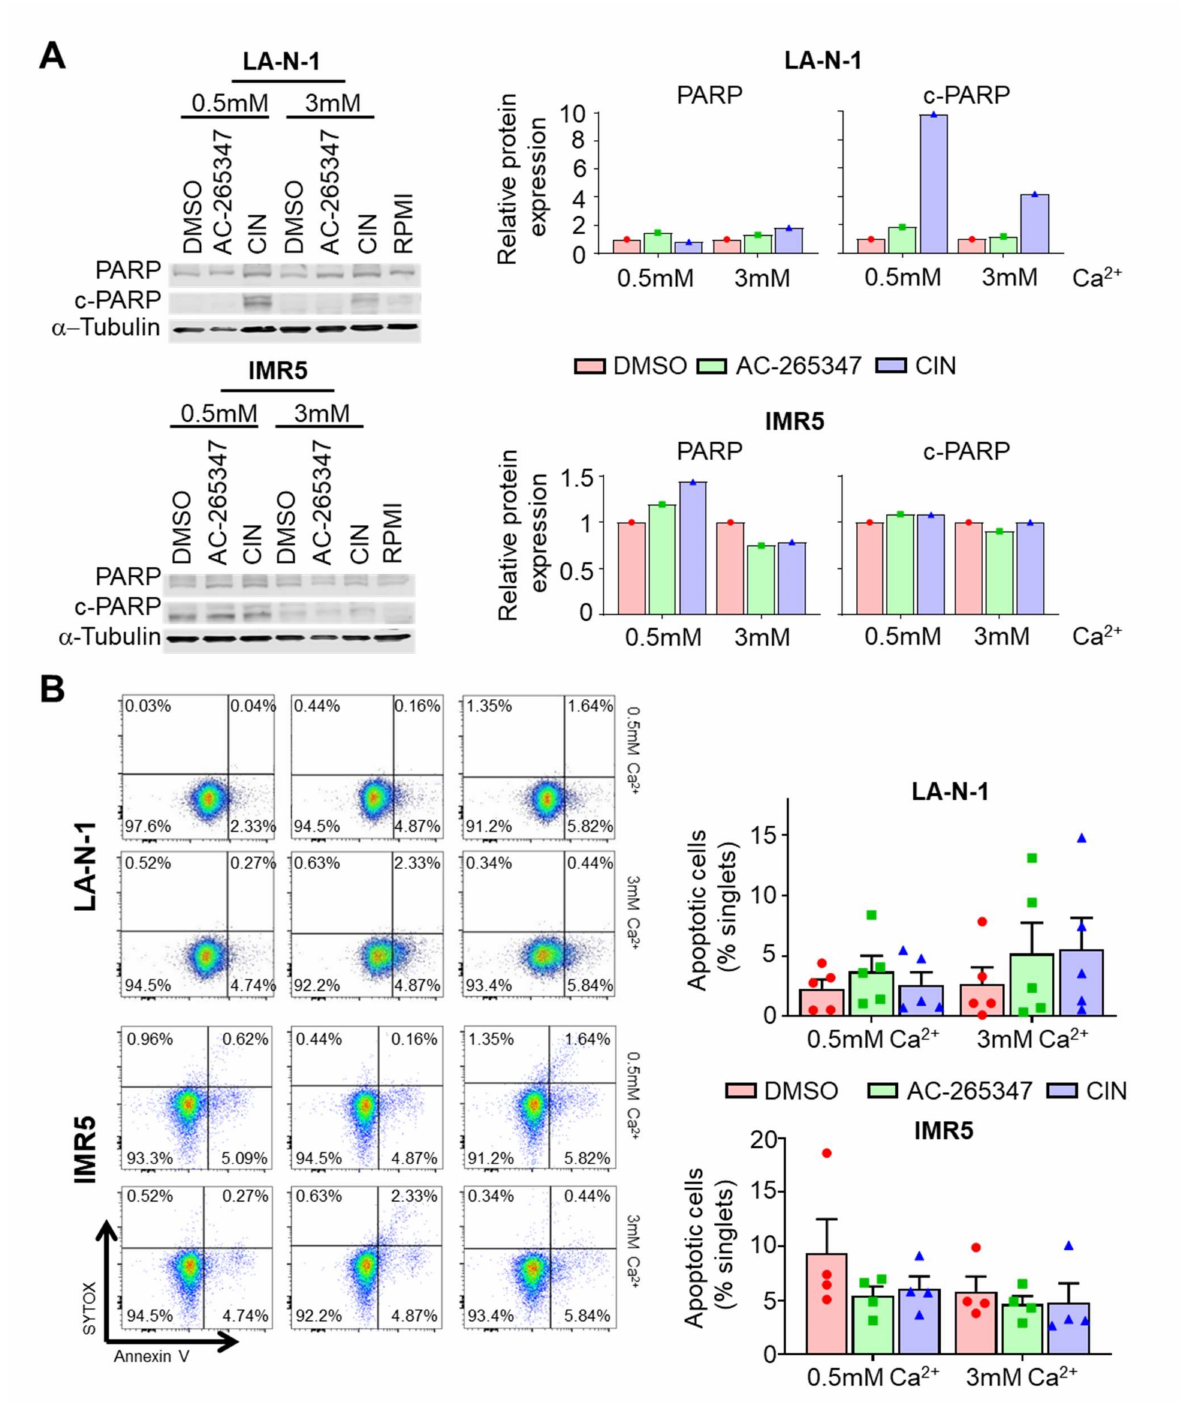
Figure 4. Acute exposure to AC-265347 differently affects NB cells. ( A ) Left: Immunoblot of cleaved- Parp (c-Parp) and full-length PARP (PARP) from LA-N-1 and IMR5 cells exposed to 1 µ M of AC- 265347, CIN or vehicle (DMSO) in the presence of 0.5 or 3 mM of CaCl 2 , for 24 h. Right: Quantification of immunoblots; bars represent band intensity relative to α -tubulin. ( B ) Left: IMR5 and LA-N-1 cells were stained with SYTOX and Annexin V after a 16-h exposure to 1 µ M of CIN, AC-265347 or their vehicle (DMSO) in the presence of 0.5 or 3 mM of CaCl 2 . Right: Annexin V positive cells in each treatment were quantified by flow cytometry. Statistical analysis between groups was calculated using a Mann–Whitney test ( p > 0.05 for all the comparisons). Each symbol represents an individual experiment and bar represents mean +